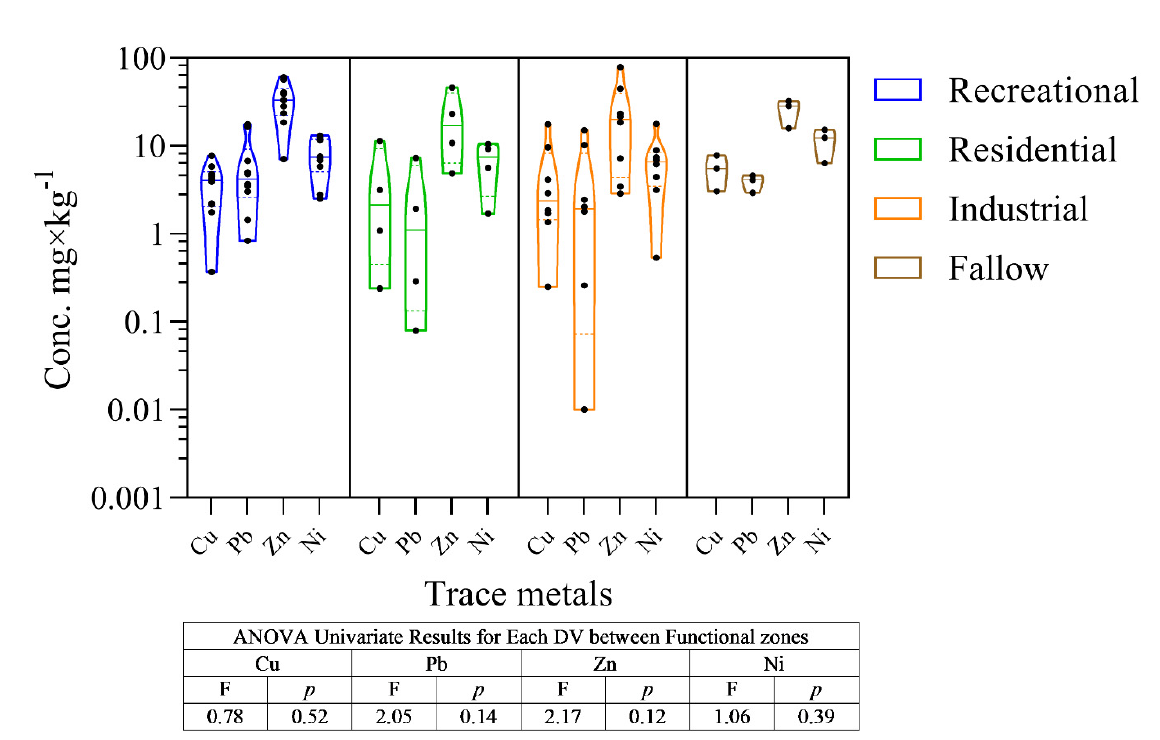
Figure 4. Variation in the content of trace metals and the results of statistical data processing.